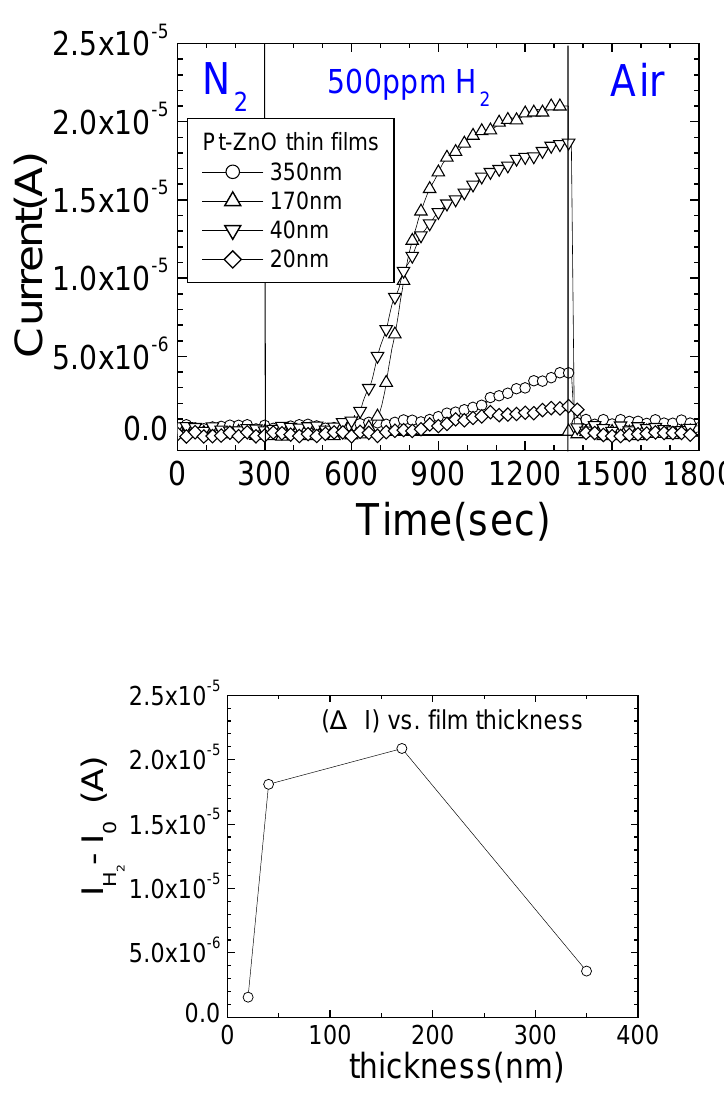
Figure 18. Current as a function of time for Pt-coated ZnO thin films of different thickness cycled from N to 500 ppm H in N to air ambient (top) and change in current at fixed bias (0.5V) when 2 2 2 switching to the H -containing ambient 2